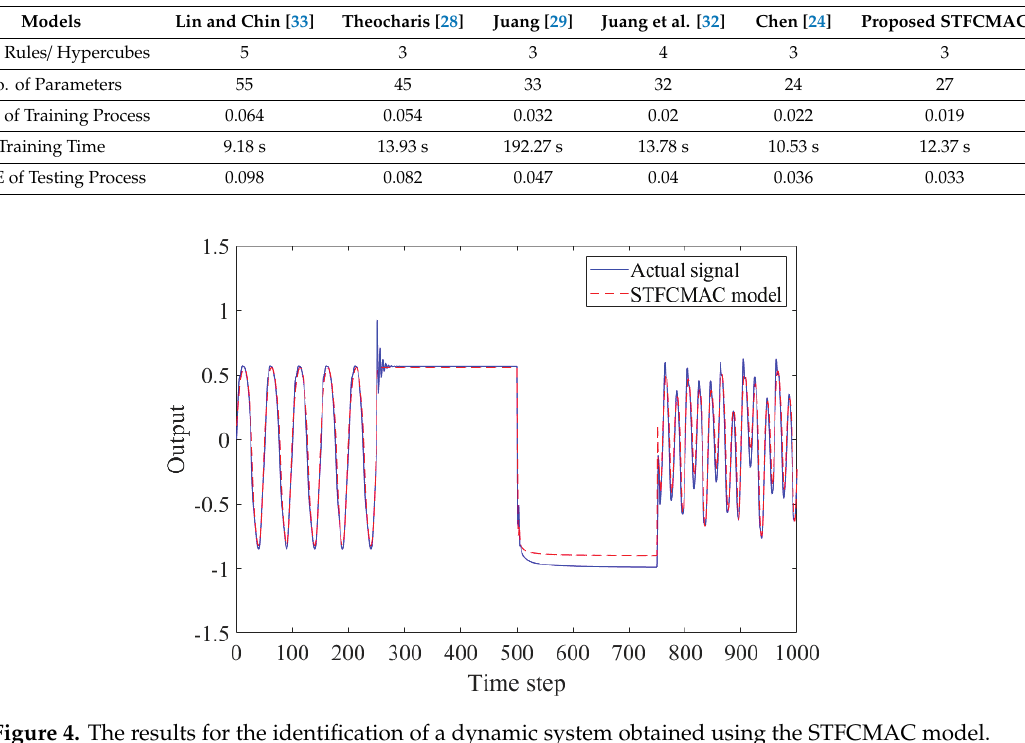
Table 1. A comparison of di ff erent identifiers in terms of dynamic system identification.